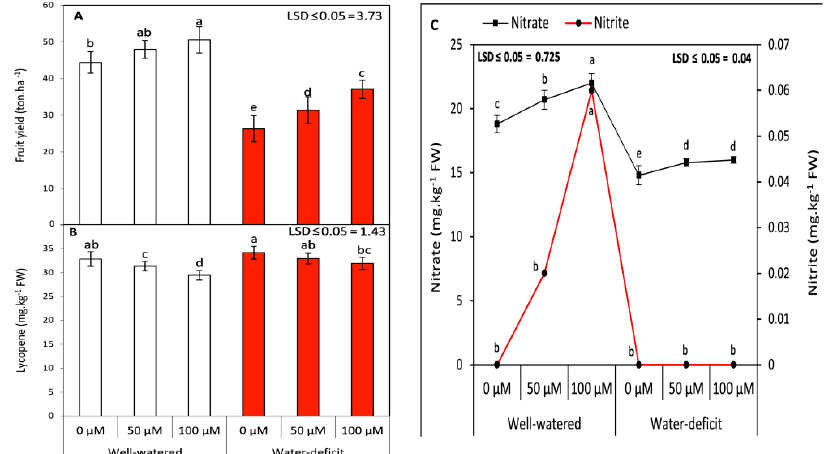
Figure 2. Effects of SNP as foliar applications at 0, 50, and 100 µ M on the fruit yield ( A ) and its contents of lycopene ( B ) as well as nitrite and nitrate ( C ) of tomato plants grown under well-watered and water deficit irrigation. Data followed by the same letters are not significantly different using the LSD multiple rang test at a 5%